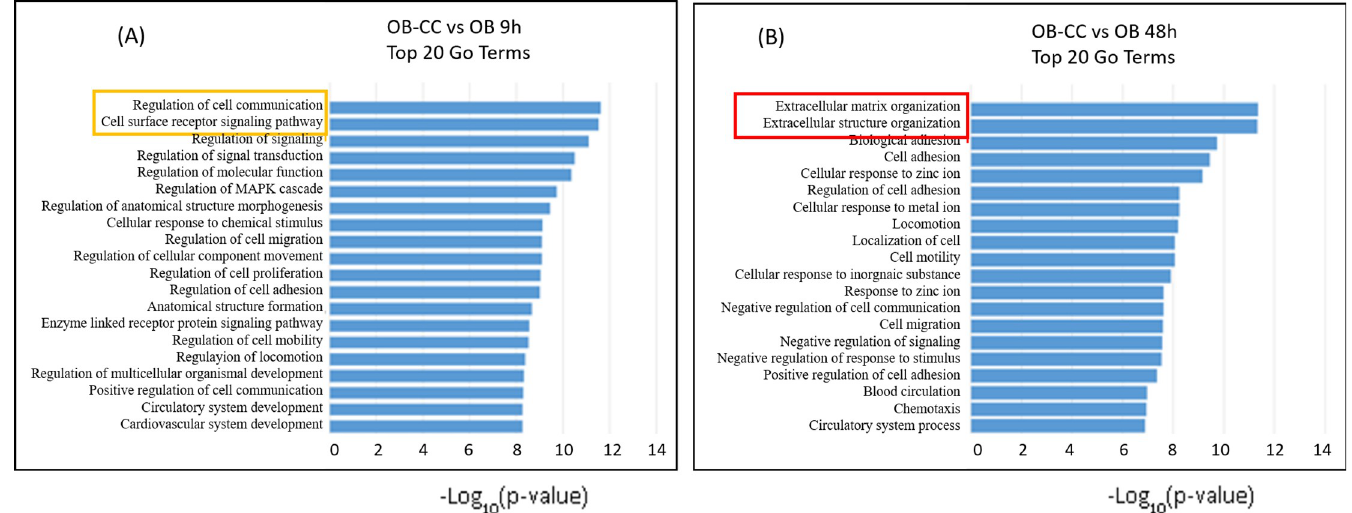
Fig 5. Osteoblasts present different phenotypic changes according to coculture duration. Top 20 GO terms of biological processes (ranked by p-value) for differentially expressed genes found between (A) OB-CC 9 h vs. OB and (B) OB-CC 48 h vs. OB. Bars represent the minus log 10 of the p-values.